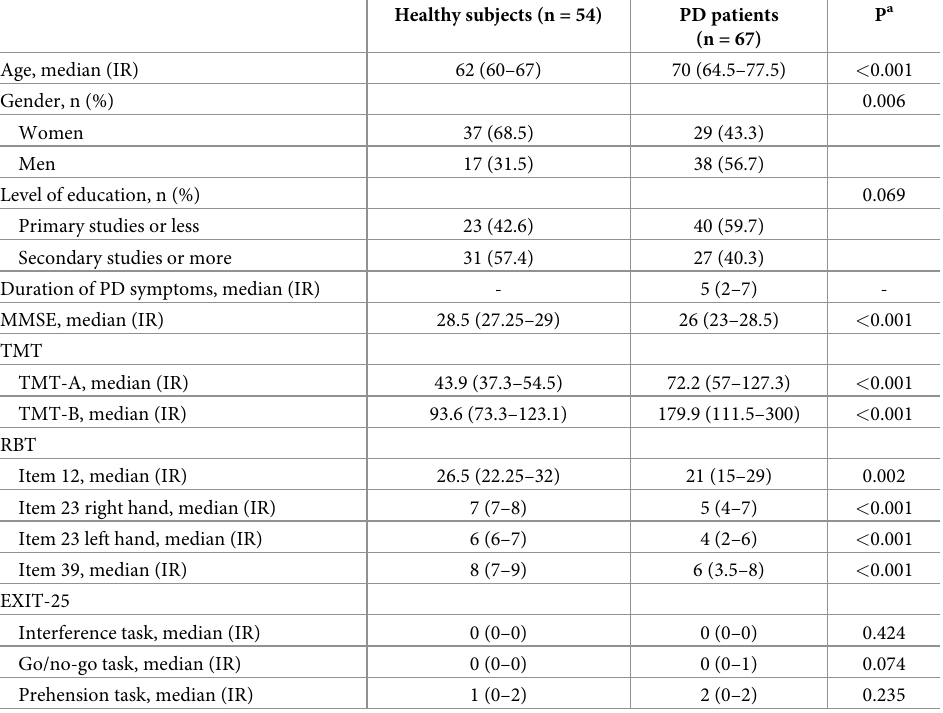
Table 1. General characteristics of study participants (n =